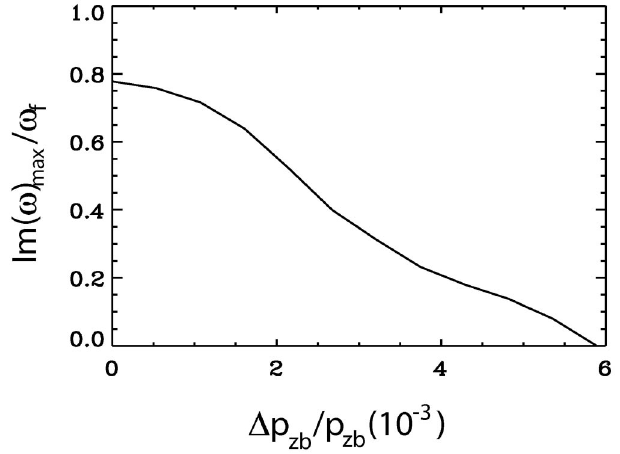
FIG. 6. The maximum linear growth rate (cid:1) Im ! (cid:2) ion-electron two-stream instability decreases as the longitudi- nal momentum spread of the beam ions increases.